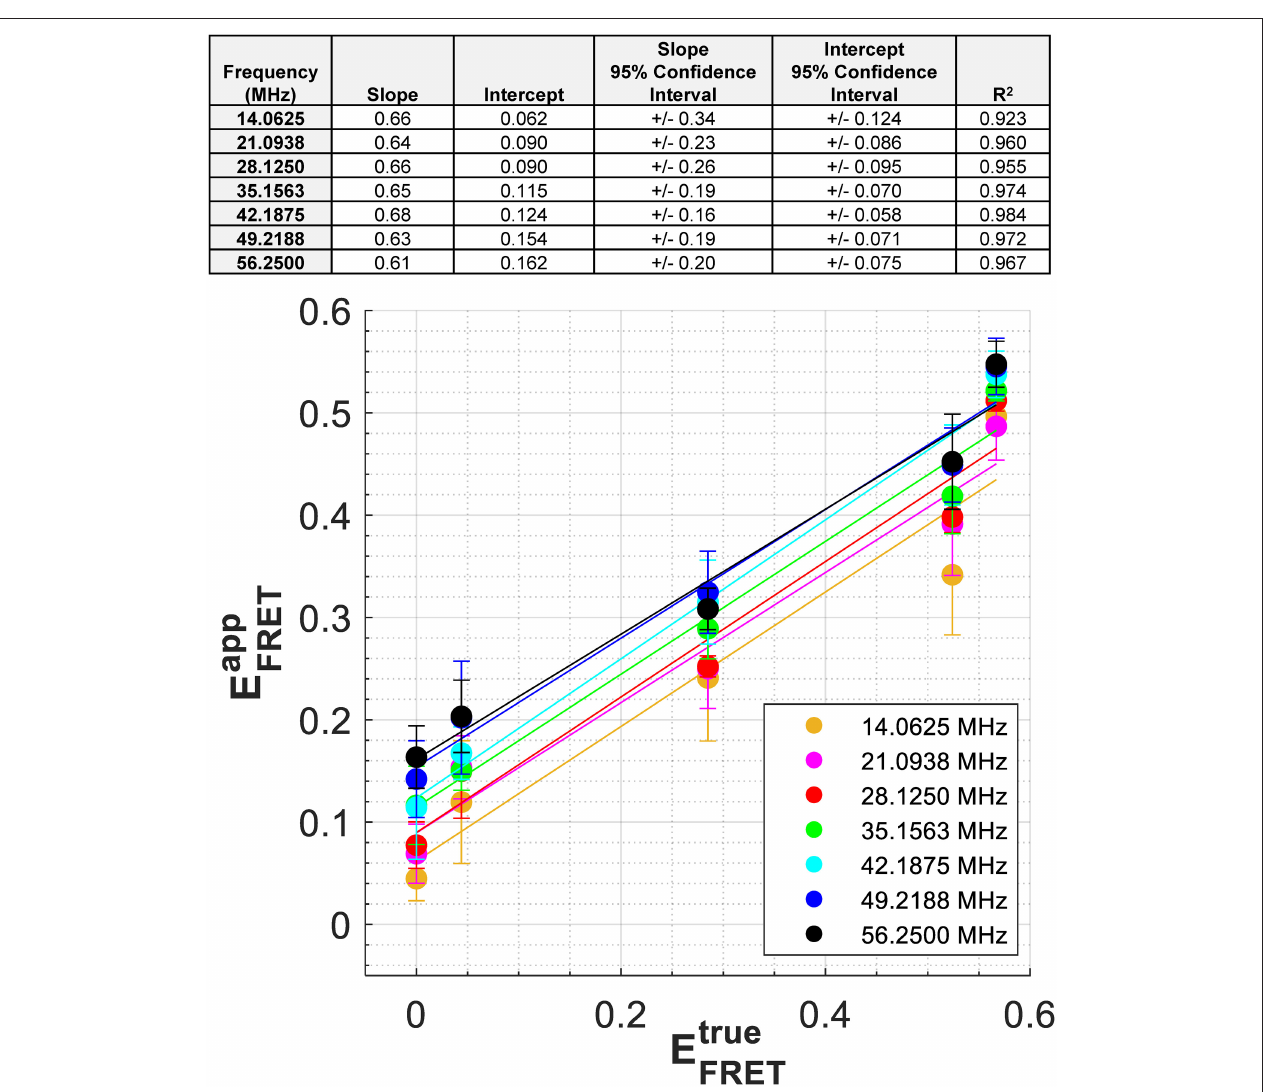
FIGURE 4 | Relationship between E app FRET and E true FRET for the protein constructs at each modulation frequency. E app FRET was calculated at each modulation frequency using the measured τ DA φ , τ D 3.11 ns, and Equation 3. For mTFP1, a non-zero intercept was taken as = lifetime measurements, τ TFP φ , that were made at each frequency While the slopes related to each modulation frequency are similar, the intercepts generally increase with increasing modulation frequency. Exact parameters of these linear fits are found in the top